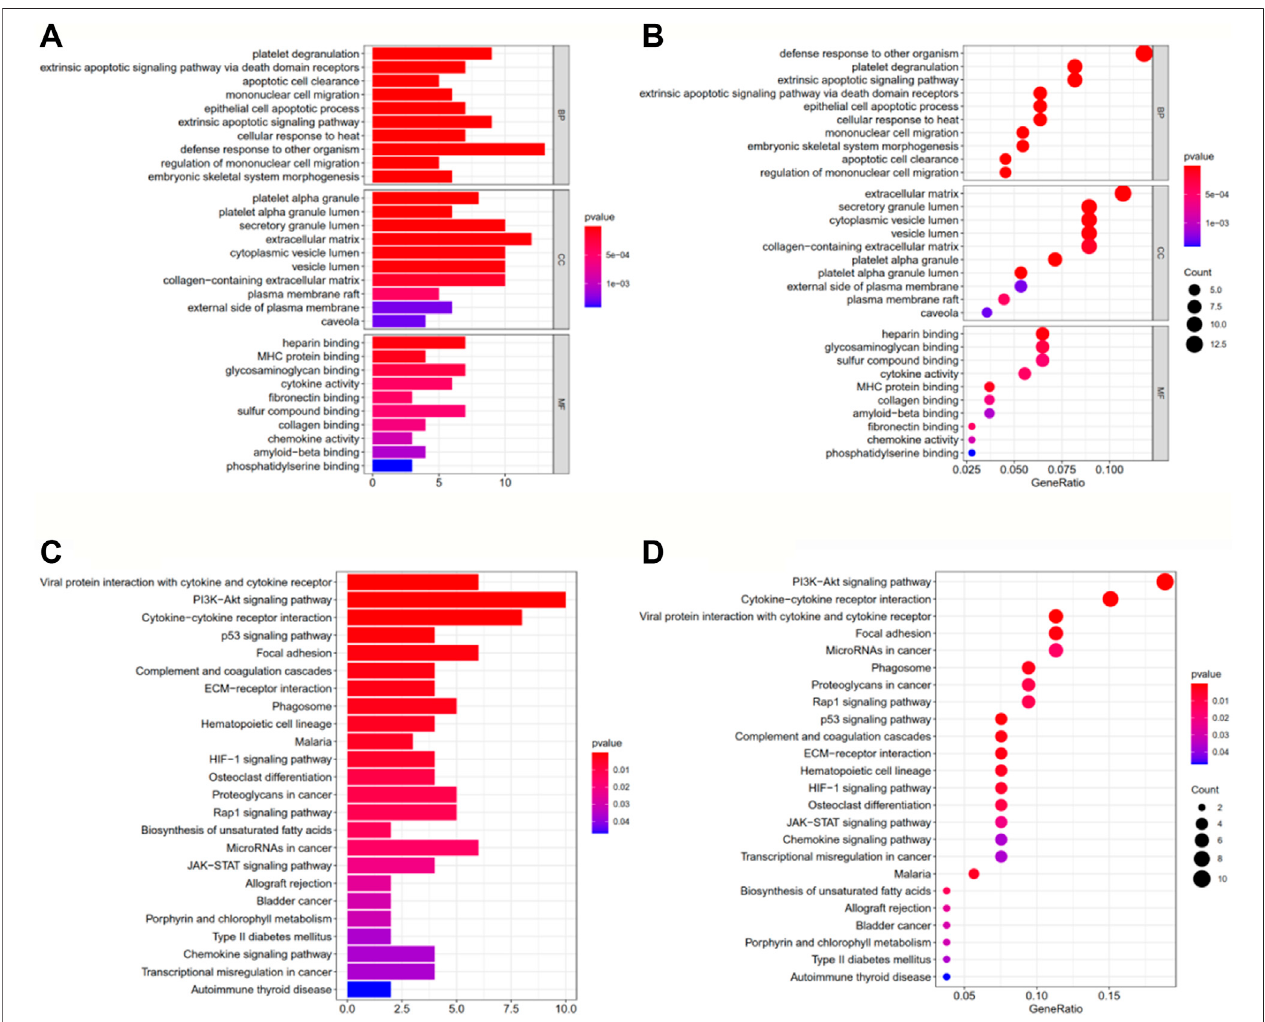
FIGURE4| GeneOntology ( GO; A,B) andKyotoEncyclopedia ofGenesand Genomes ( KEGG; C,D) enrichmentanalysesofdifferentially expressed genesinthe training set TCGA-LAML. (A, B) The top 10 results of the GO enrichment analysis. (C, D) are the most signi fi cant KEGG pathways. In the bar charts (A, C) , the length of each column represents thenumber ofgenesenriched,withlongercolumnsindicatingmore enriched genes.Thecolorsofthecolumns represent thesigni fi canceofthe enrichment, with redder columns being more signi fi cant. In the bubble diagrams (B, D) , the sizes ofthe circles represent the number ofgenes enriched, withlarger circles indicating more genes enriched. The colors of the circles represent the signi fi cance of the enrichment, with the redder circles being more signi fi